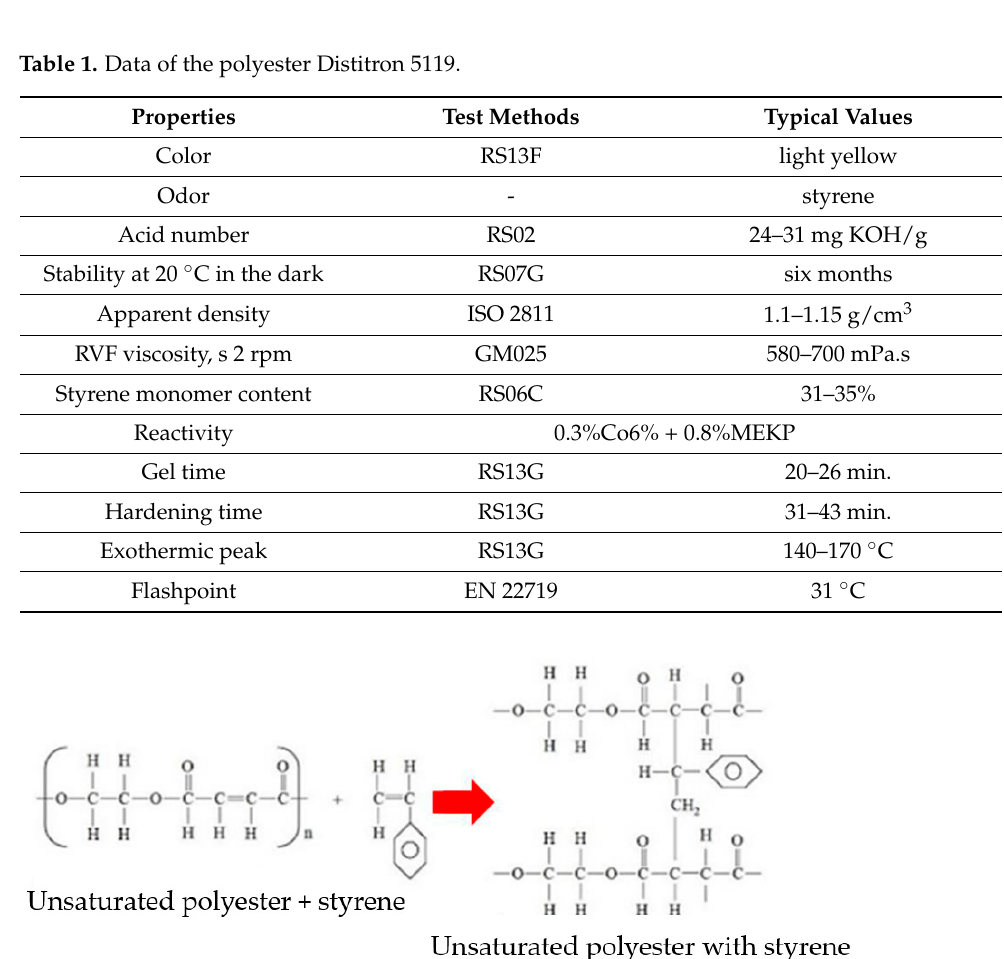
Figure 2. Obtaining unsaturated polyester with styrene.